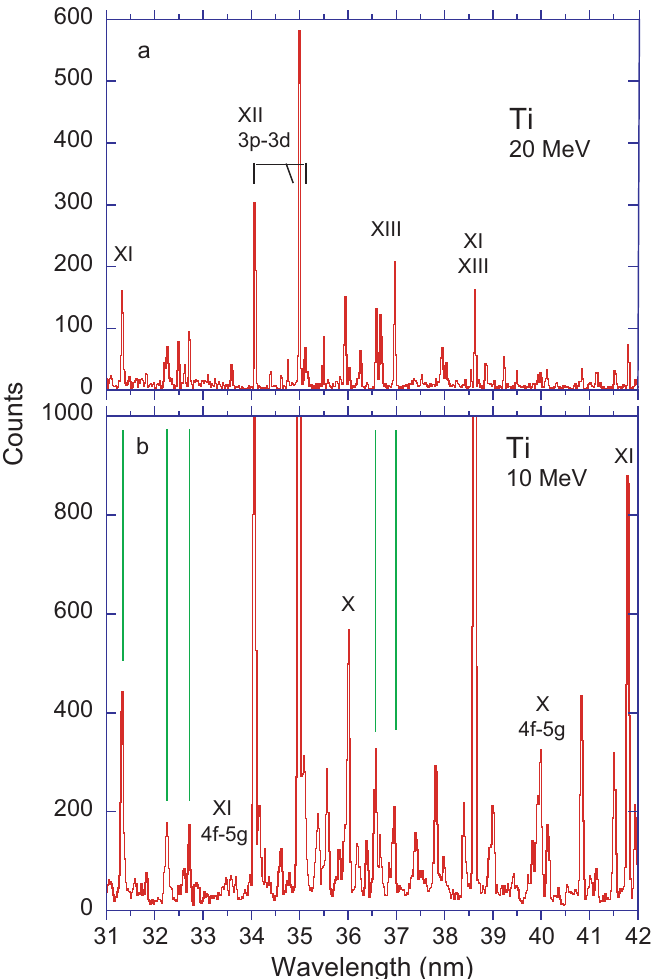
Figure 6. Continuation of the Ti spectra shown in Figures 4 and 5. ( a ) ion beam energy 20 MeV, ( b ) ion beam energy 10